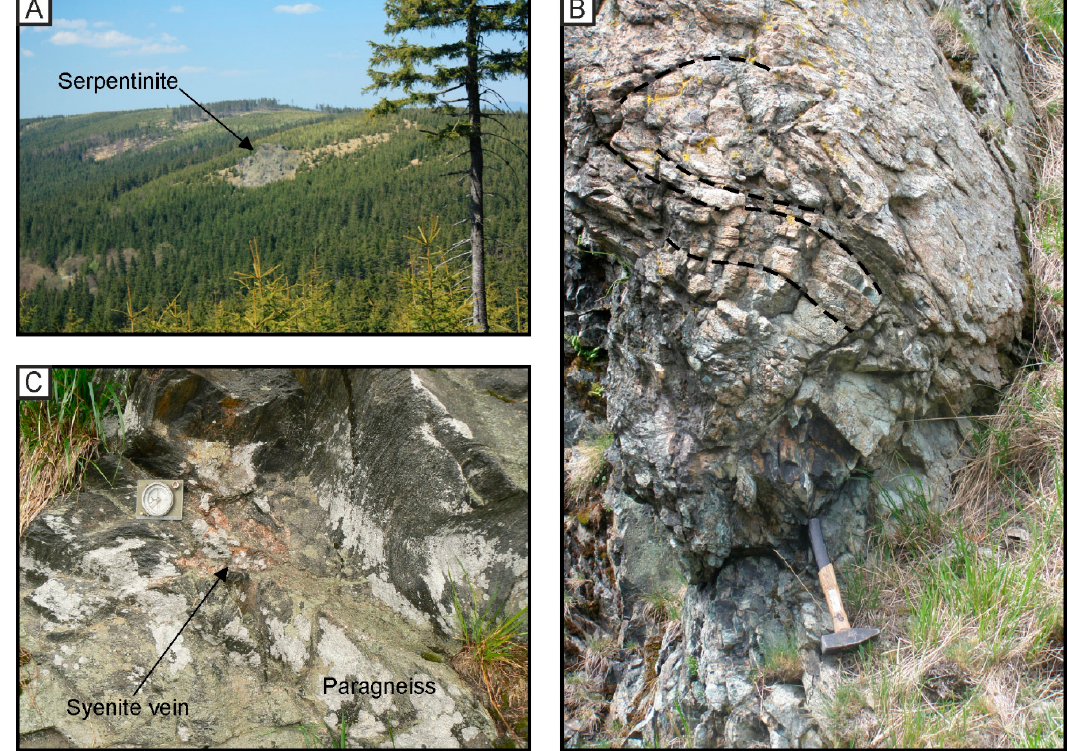
Figure 3. Examples of field occurrences. ( A ) Serpentinite outcrop at the Ż mijowiec Rib (photo taken from the top of Mount Ś nie ż nik); ( B ) Schistosity in serpentinite (selected planes are highlighted); ( C ) Syenite vein in the country paragneiss few tens of meters away from serpentinite.